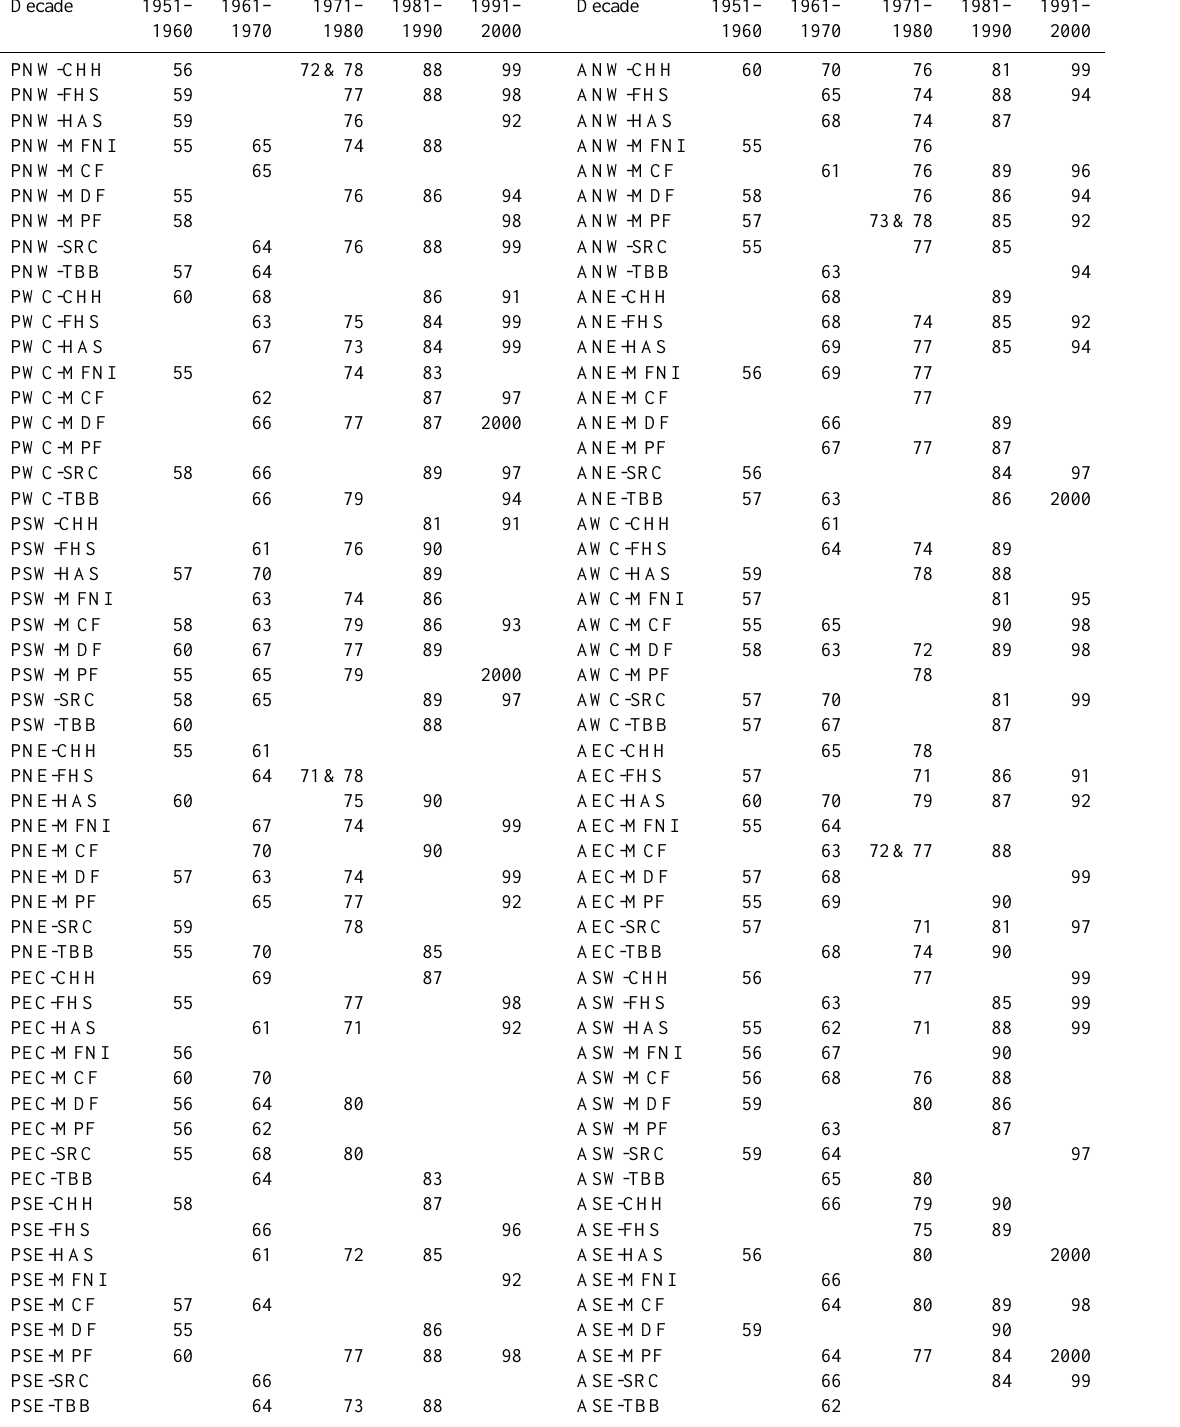
Table A2a. Listed years of fish landing regime shift occurrence by region and species consolidated by decade from 1950 to 2008. (a) Indicates the fish species over the Atlantic and Pacific